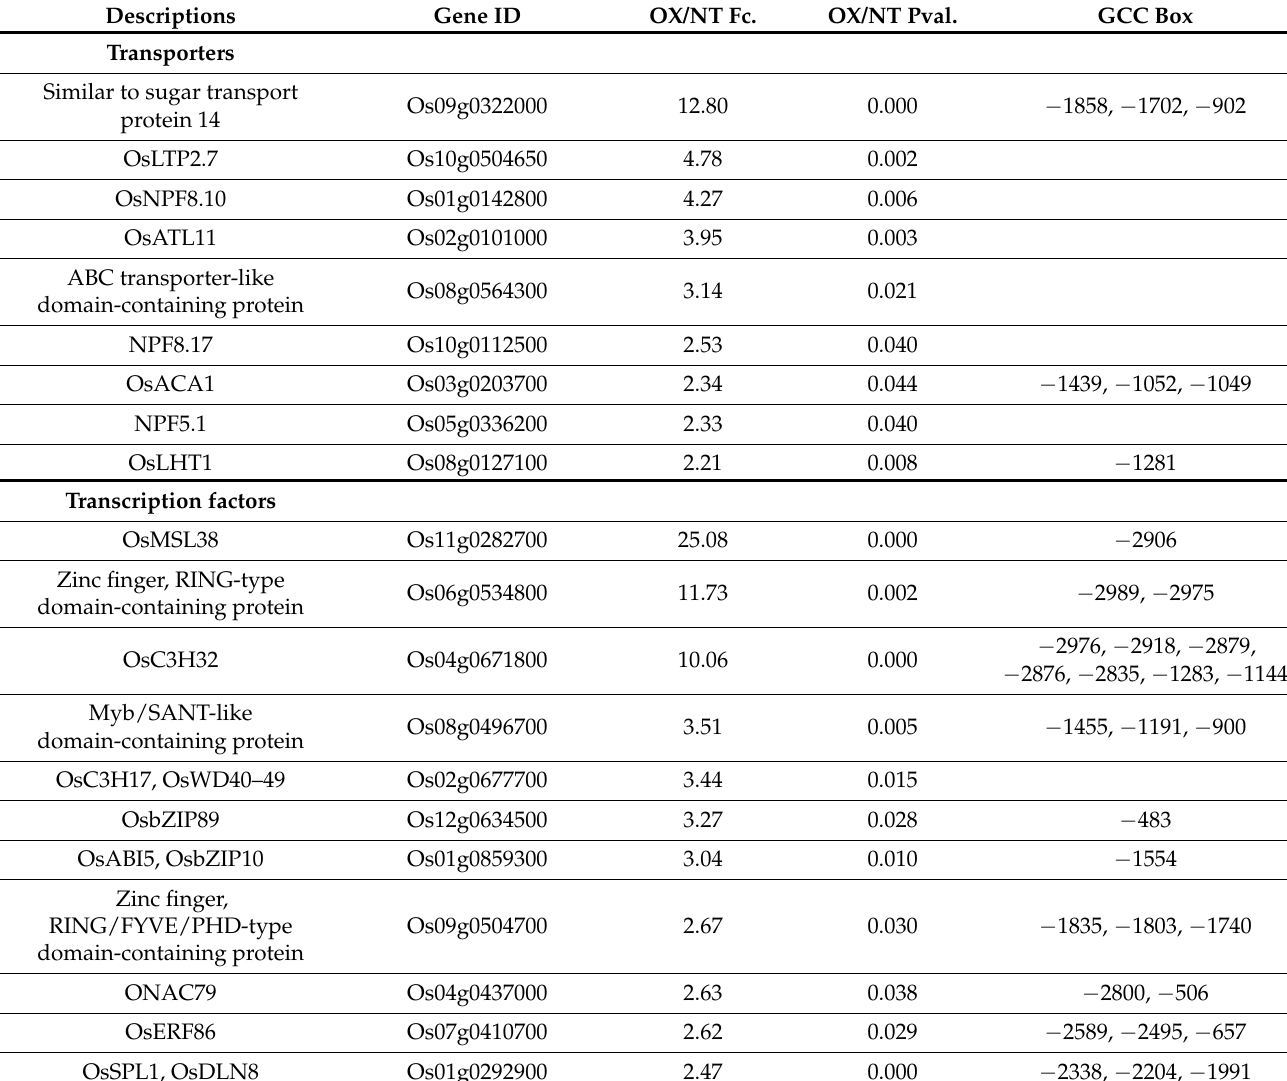
Table 1. List of genes up-regulated (>2-fold) in OsERF83-MYC OX and drought treatment in shoots and